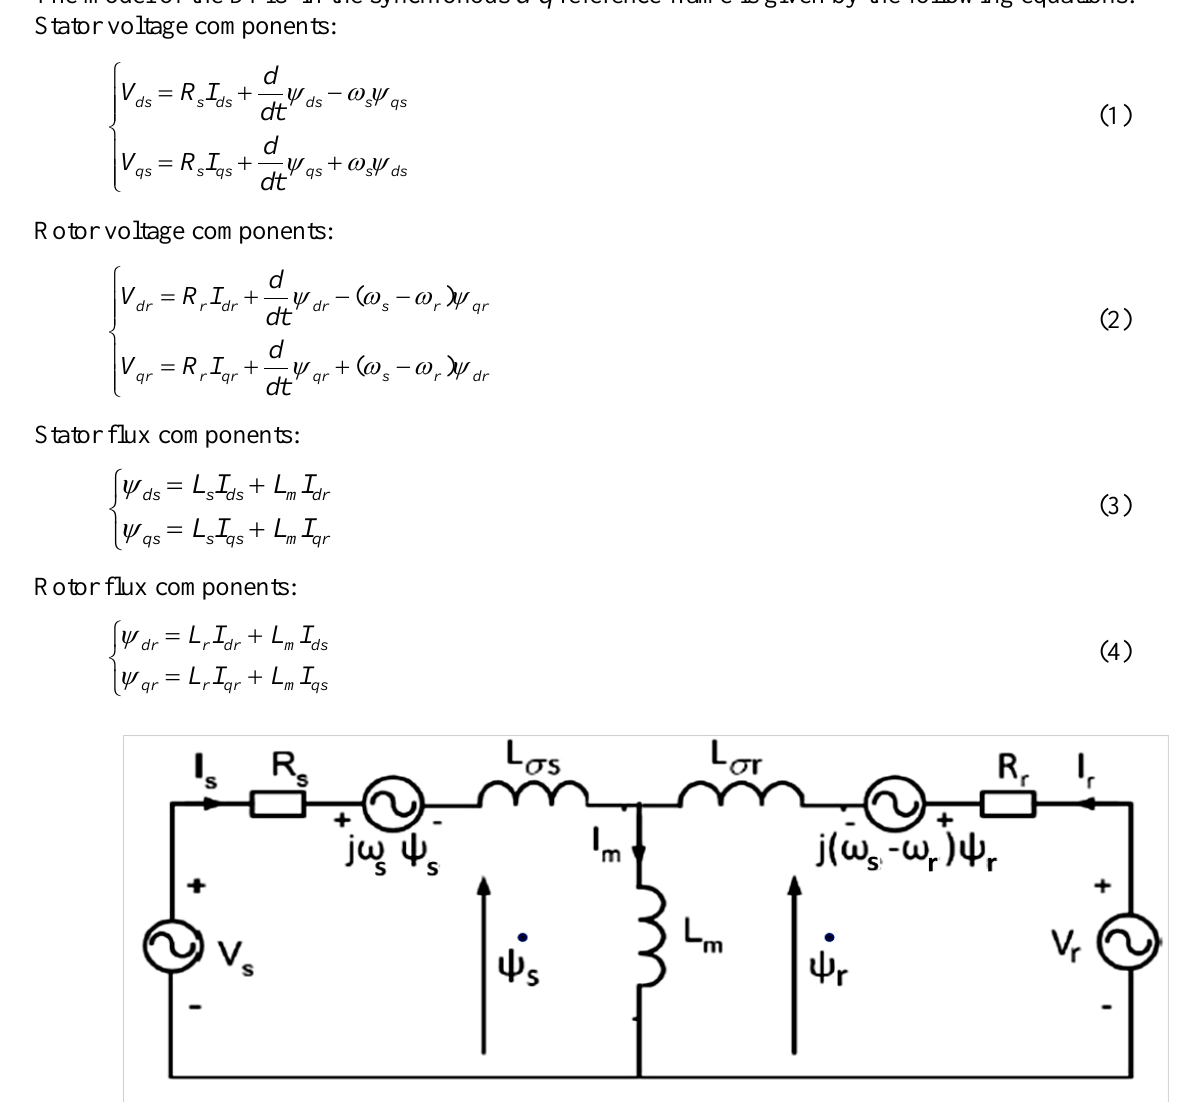
Figure 2. DFIG equivalent circuit in the synchronous reference